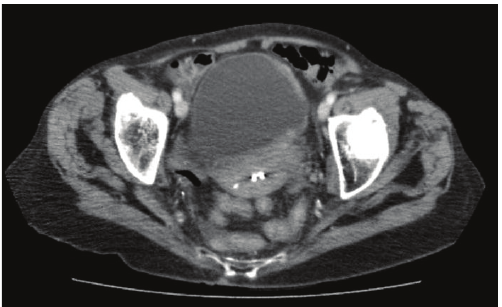
Figure 1: Abdominal and Pelvic CT showing a thickened posterior and left lateral wall.